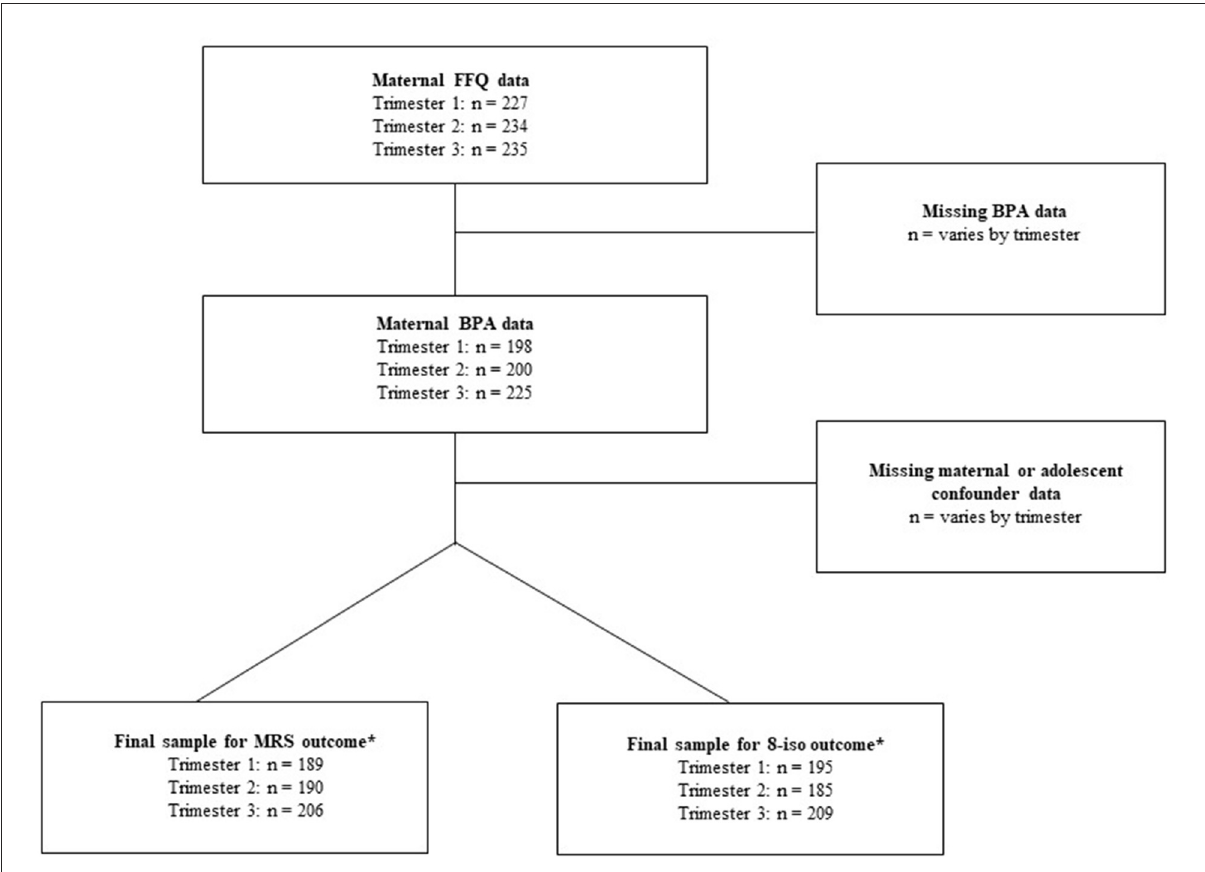
FIGURE1 Study flow chart. *Sample sizes from fully adjusted regression